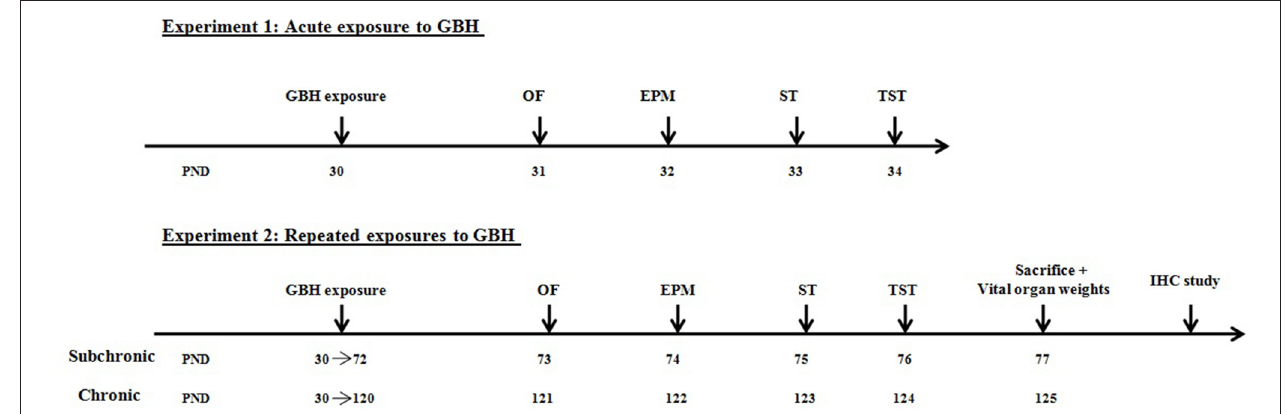
FIGURE 1 | Experimental design of the acute and repeated exposures to glyphosate based herbicide (GBH) in male